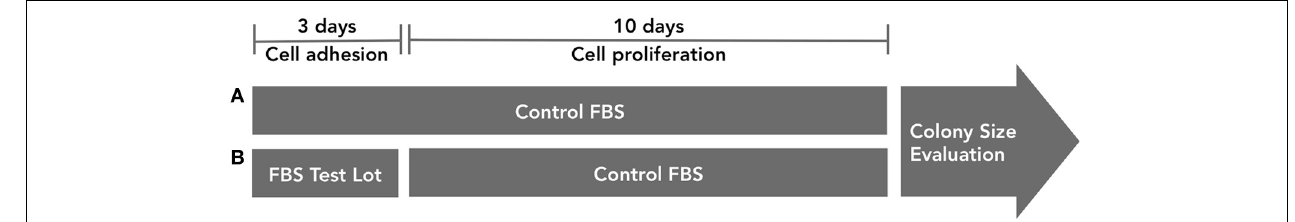
FIGURE 5 | FBS influence on progenitor cell adhesion in vitro must be tested. In group (A) , bone marrow cells are incubated in culture medium supplemented with control serum. After 72h, non-adherent cells are discarded and adherent cells are cultured for 10 additional days also in culture medium supplemented with control FBS. In group